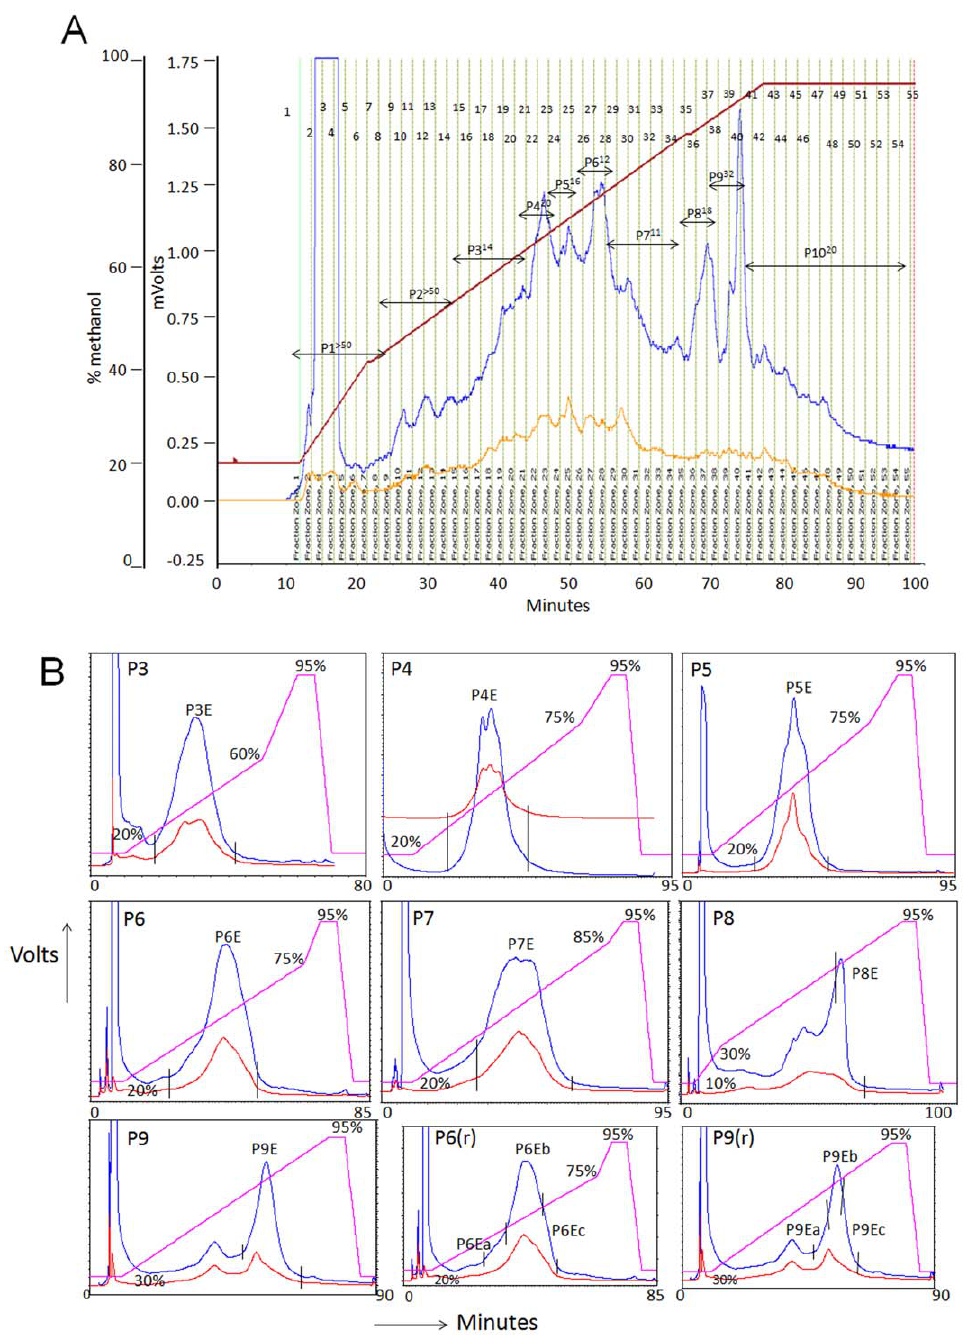
Figure 3. 2 nd and 3 rd dimension RPHPLC fractionation of Harshringar Leaves extract. Panel A shows semi-prep RPHPLC of 60%–80% MF of Harshringar leaves. 55 fractions (indicated as numbers against fraction bars) were collected, judiciously pooled as indicated by horizontal lines to obtain 10 pools (P1–P10). A 214 (blue line) and A 280 (brown line). Superscripts represent IC 50 ( m g/mL) values against P.falciparum 3D7. Panel B shows 3 rd dimension RPHPLC chromatograms of pools P3–P9 of Harshringar leaves. All chromatograms were acquired at 214 nm (blue line)/280 nm (red line) except P6 and P9 which were acquired at 214 nm (blue line)/254 nm (red line). , 2 mg/200 m L of each of the pools (P3–P9) was injected onto an analytical reverse phase C 18 column (Deltapak, C 18 , 300 6 7.8 mm, 15 m , 300 A˚) using acetonitrile-water linear gradient (pink line with % values indicating % acetonitrile) at a flow rate of 2 mL/min. Peaks were collected as shown by vertical lines and denoted as P3E–P9E (Table 1). P6 and P9 were rechromatographed ({P6 (r) and P9 (r)} to collect each peak into three slices of sub fractions (P6Ea–P6Ec, P9Ea–P9Eb). Peaks and peak fractions were assayed for antiplasmodial potency against P.falciparum .